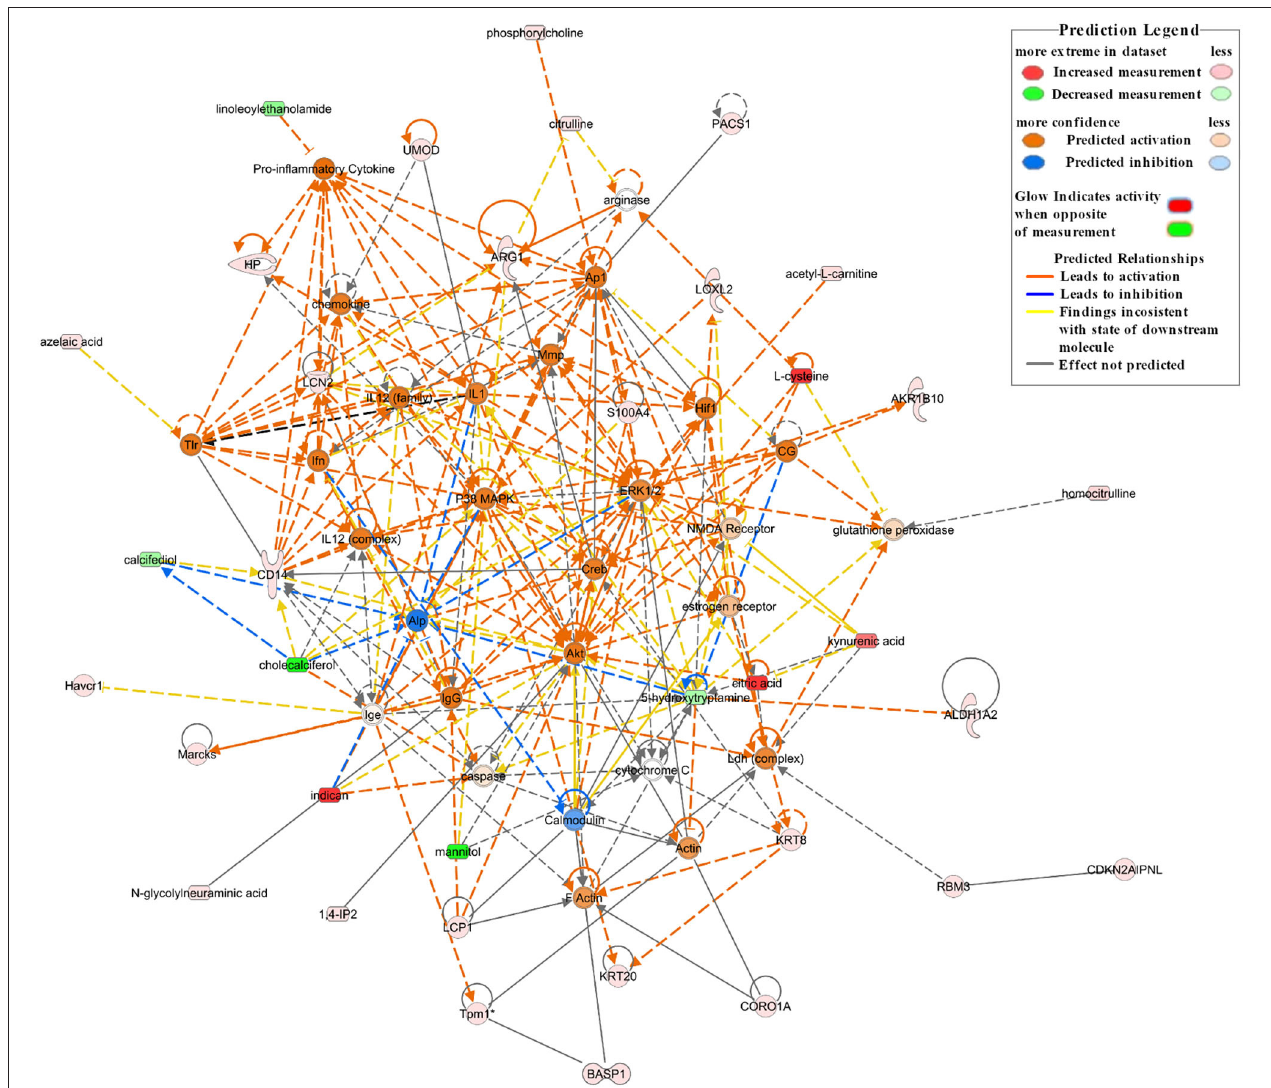
FIGURE 4 | The top network associated with immunological disease, inflammatory disease, and inflammatory response based on the significantly differentially expressed proteins and metabolites between the Crystal group and Control group. Red shapes represent upregulated molecules and green shapes represent downregulated molecules. Prediction legends are annotated in the legend